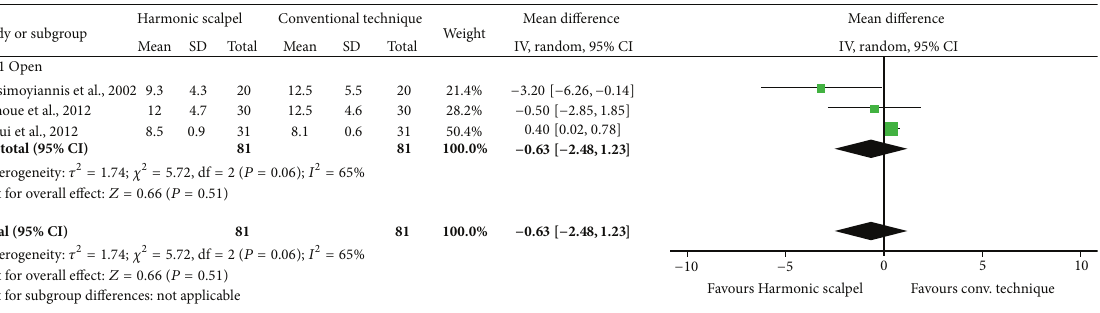
Harmonic scalpel